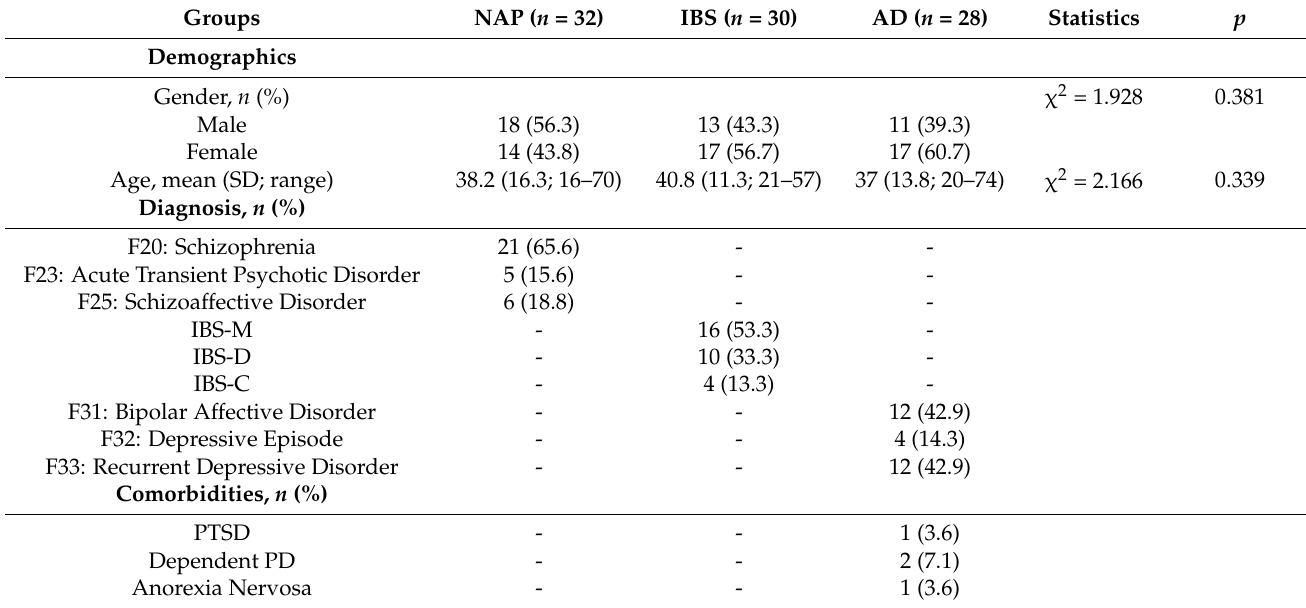
Table 1. Demographics and clinical data of the sample ( N =